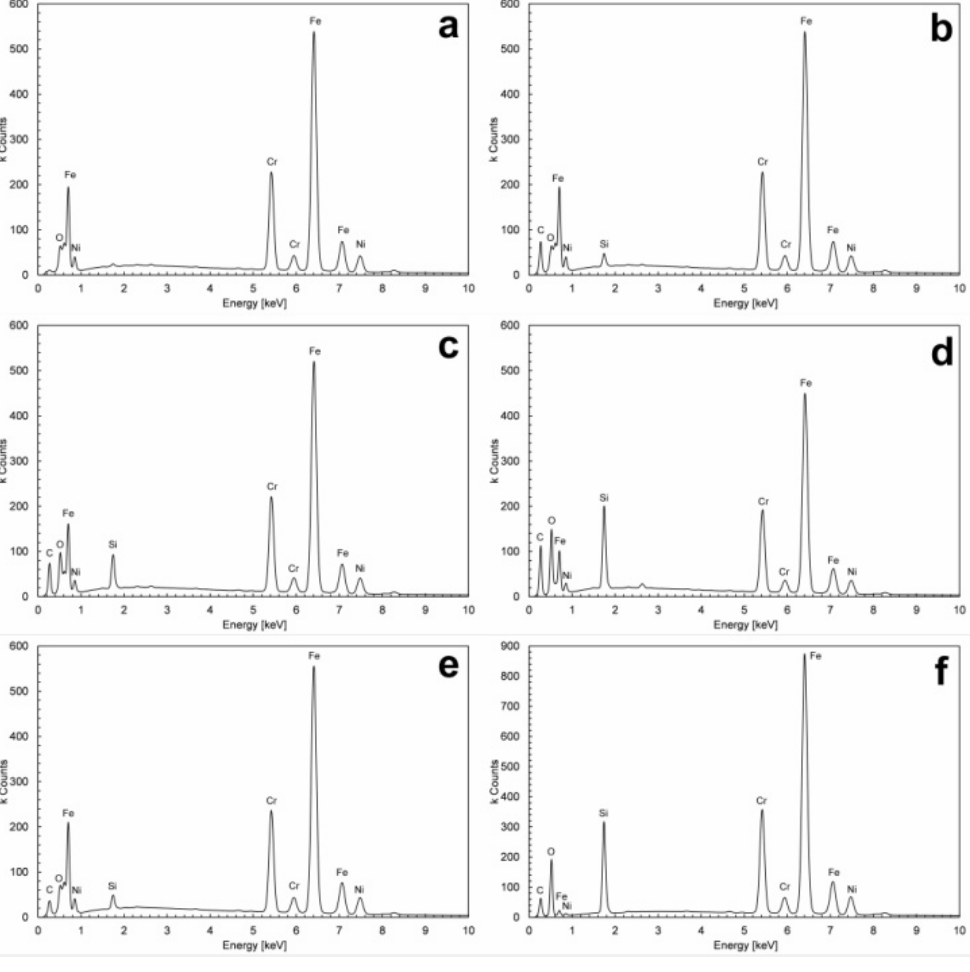
Figure 2. Energy-dispersive X-ray spectroscopy (EDS) results of ( a ) 304 stainless steel after acetone and hot 10% KOH solution treatment; ( b ) sample R1; ( c ) sample R2; ( d ) sample R3; ( e ) sample R4; ( f ) sample R5.